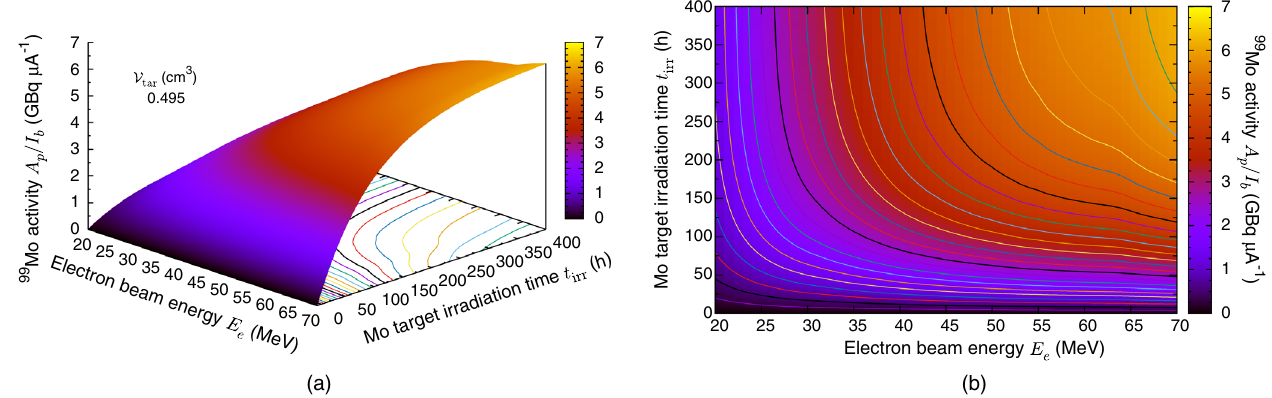
FIG. 5. (a) 99 Mo activity calculated from Eq. (5), varying with electron beam energy and enr Mo target irradiation time; and (b) its two- dimensional projection. The contour lines begin at 0 . 25 GBq μ A − 1 from the bottom and are spaced by 0 . 25 GBq μ A − 1 .